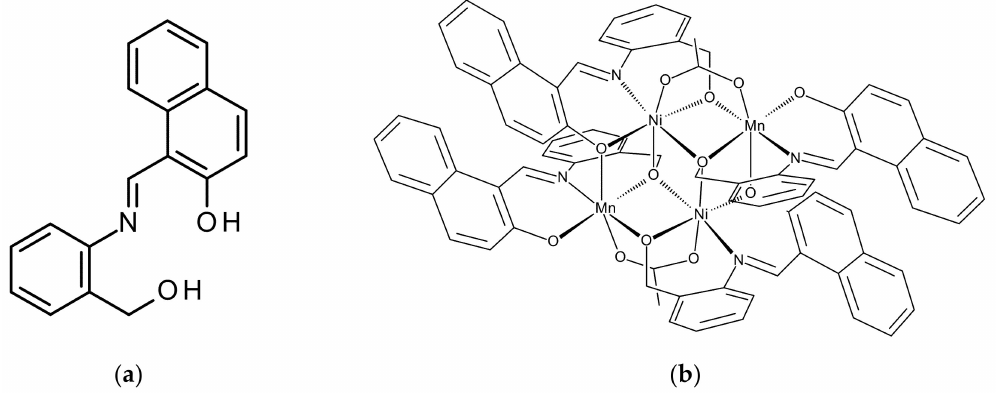
Figure 1. Chemical diagram of ( a ) ligand H 2 L and ( b ) [MnNi(L) 2 (OAc)] 2 ( 1